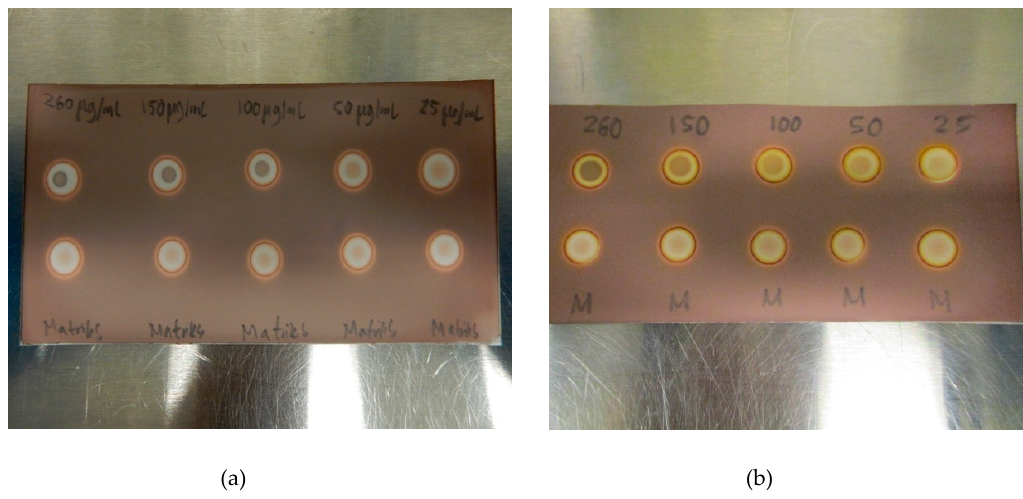
Figure 5. ( a ) LoD determination for TBA in the [ 18 F]PSMA-1007 matrix without antioxidant and. ( b ) LoD determination for TBA in the [ 18 F]PSMA-1007 matrix with antioxidant.